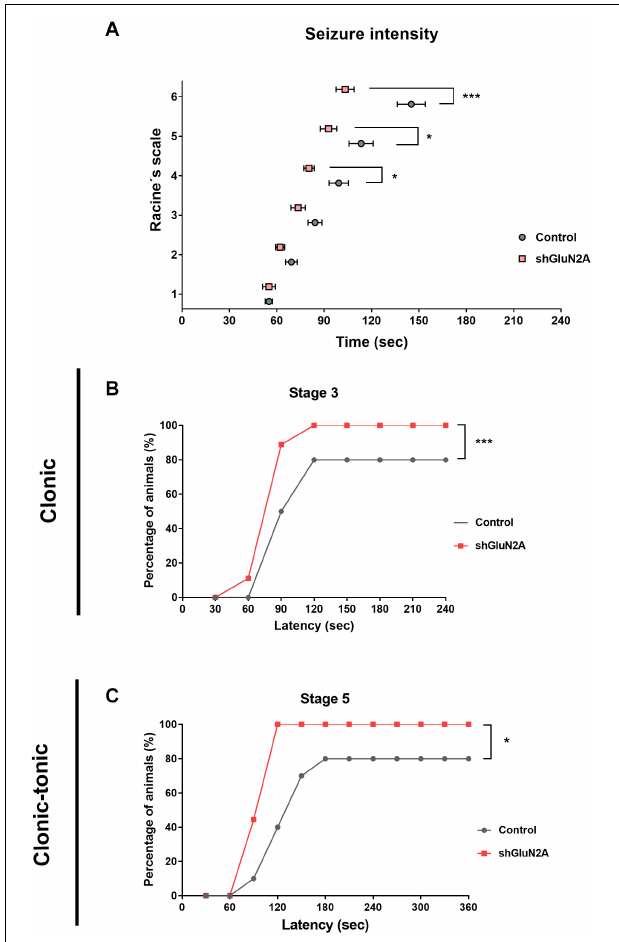
FIGURE 7 | Seizure susceptibility analysis. shGLUN2A- and shsc-injected animals were injected intraperitoneally with a convulsive drug (PTZ, 50 mg/kg) or saline i.p. All animals were monitored after the injection and seizure intensity was evaluated by Racine scale. (A) shGLUN2A-PTZ–injected animals reached the highest stages in Racine scale earlier than shsc-PTZ injected ones (* p < 0.05, *** p < 0.001, unpaired t test). (B,C) There was a significant difference in the percentage of shGLUN2A-injected animals that showed clonic ( B , *** p < 0.001, two-way ANOVA, Tukey posttest) and clonic–tonic seizure stages ( C , * p < 0.05, two-way ANOVA, Tukey posttest) compared to the shsc-injected animals. Data are represented as mean ± SEM. PTZ injected animals: N = 8 shsc-injected, N = 8